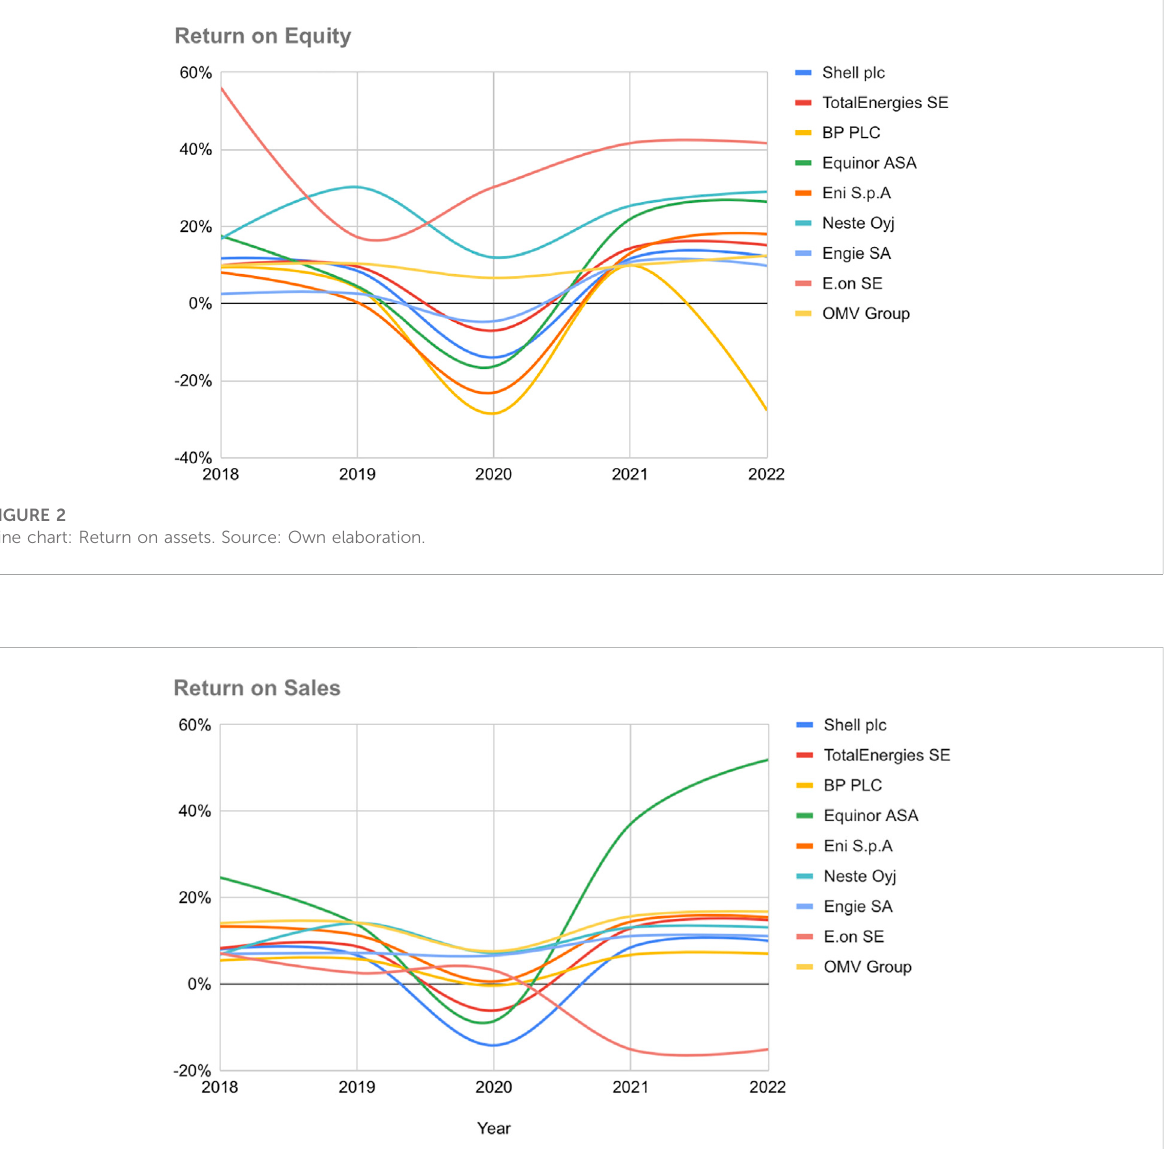
FIGURE 3 Line chart: Return on sales. Source: Own